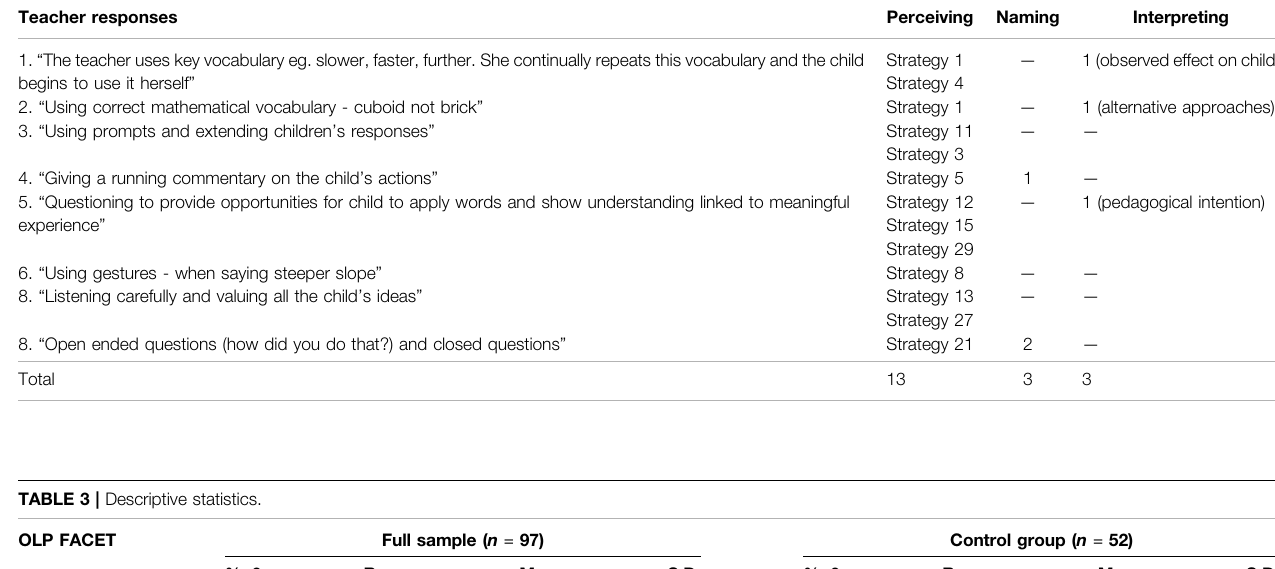
TABLE 2 | An illustrative set of coded responses to Video 1 Teacher responses